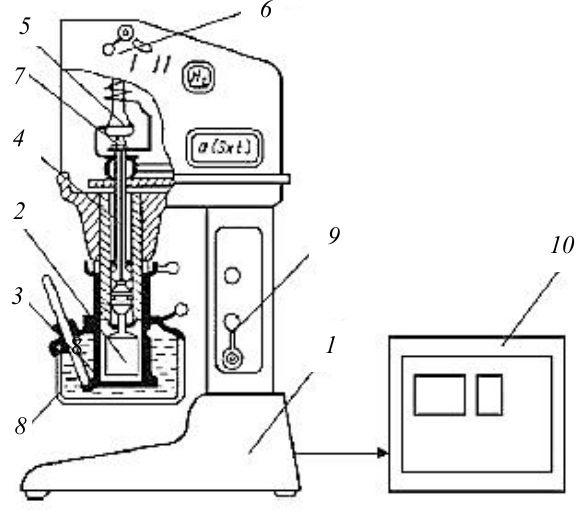
Fig. 1. Functional diagram of the measuring unit: ( 1 ) a bed; ( 2 ) a measuring cylinder (inner); ( 3 ) a measuring tank (outer cylinder); ( 4 ) a measuring shaft; ( 5 ) a drive shaft; ( 6 ) a dynamometer (spiral spring); ( 7 ) a potentiometer; ( 8 ) a thermostatic tank; ( 9 ) a shift lever; ( 10 ) an indicating